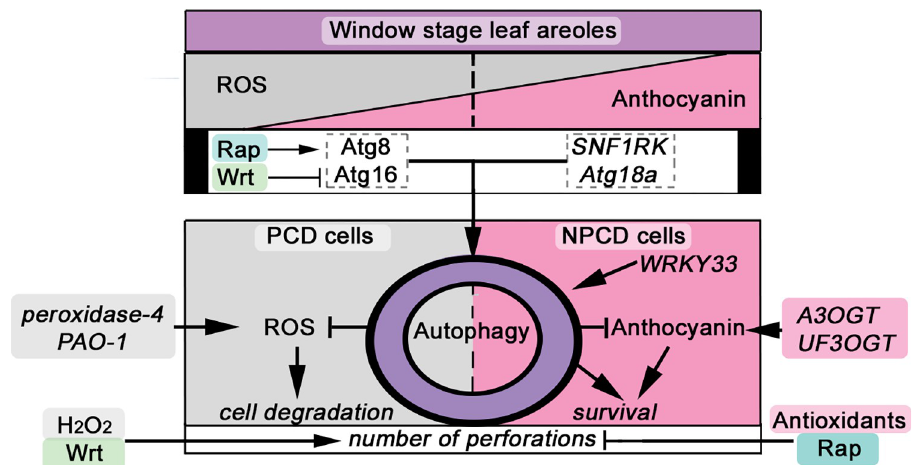
Fig 5. Diagram of potential interactions between lace plant PCD, ROS, anthocyanin, autophagy and pertinent genes. An unknown induction signal(s) during window leaf development initiates the differentiation of PCD from NPCD cells within the areole, visible by an imbalance between reactive oxygen species (ROS) and anthocyanin [16]. RNA-Seq analysis has shown that window leaves up-regulate genes such as Atg18a and SNF1RK that promote autophagy [46]. During window stage of leaf development Atg8 [29] and Atg16 protein levels are high and can be manipulated by autophagy modulators [this study, 56]. PCD cells up-regulate ROS [16] and ROS generating genes peroxidase-4 and primary amine oxidase-1 ( PAO-1 ) while NPCD cells up-regulate anthocyanidin ( A3OGT ) and UDP flavonoid-3-O-glucosyltransferases ( UF3OGT ) that promote the production of anthocyanins and a WRKY33 transcription factor that promotes autophagy [46]. Wortmannin (Wrt) and exogenous ROS in the form of H 2 O 2 have similar effects on window stage leaves possibly accentuating cell death and the ROS-anthocyanin gradient imbalance [this study, 16]. On the other hand, rapamycin (Rap) and exogenous antioxidants inhibit anthocyanin accumulation [this study, 16, 48], cell death [29] and perforation formation [This study, 48]. When the ROS-anthocyanin imbalance threshold is not reached this consistently leads to inhibited lace plant PCD [16, 48, 60]. Under normal conditions autophagy can mediate ROS [80] and anthocyanin levels (this study). How autophagic activity, the ROS-anthocyanin ‘gradient’ and associated molecular targets all mediate PCD and intracellular communication between PCD and NPCD cells requires further investigation.